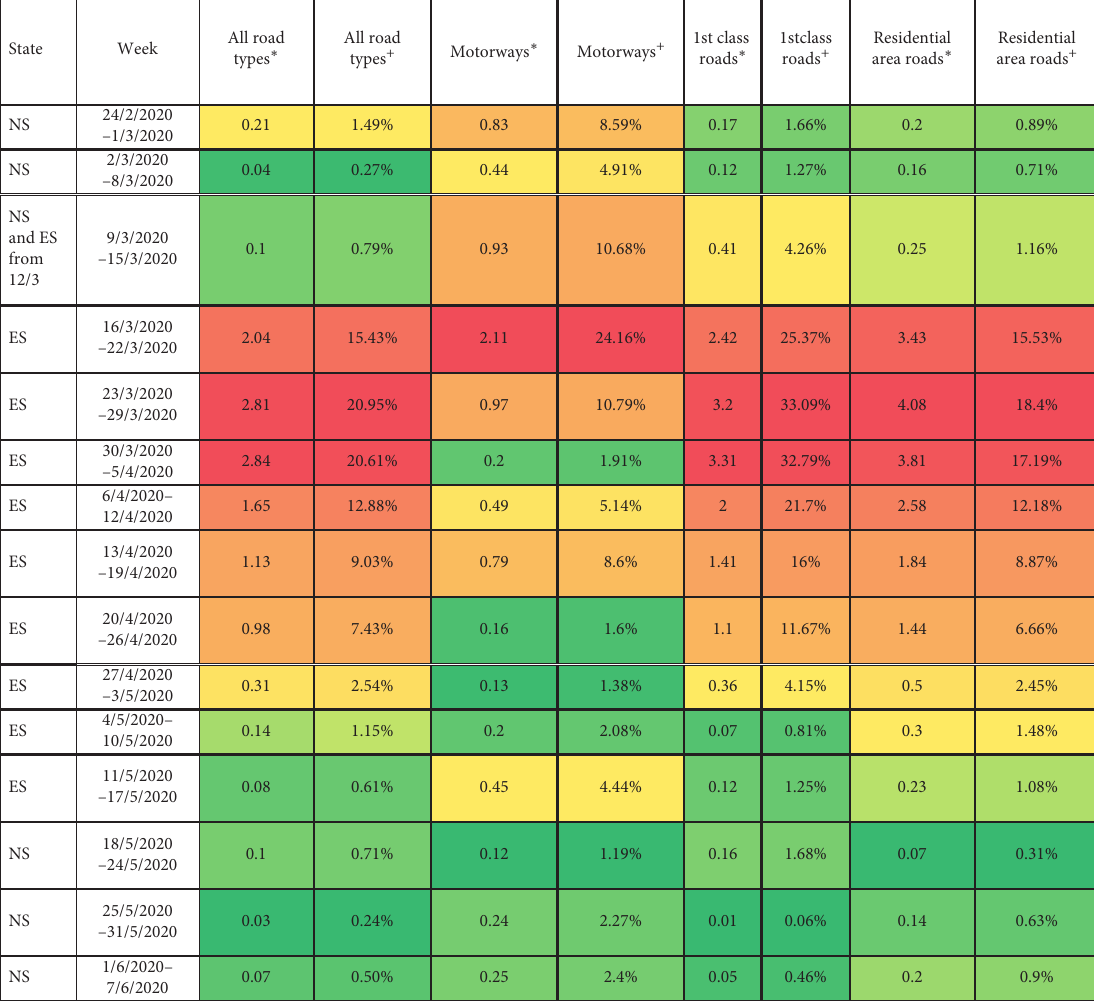
Table 3: In this variant of Table 2, cells are highlighted depending on how great the difference is between SpeedDiffRel of the estimations of the prediction model and the measured values from FreeFlowSpeed. Red highlights refer to a great difference, and green highlights only to a very small